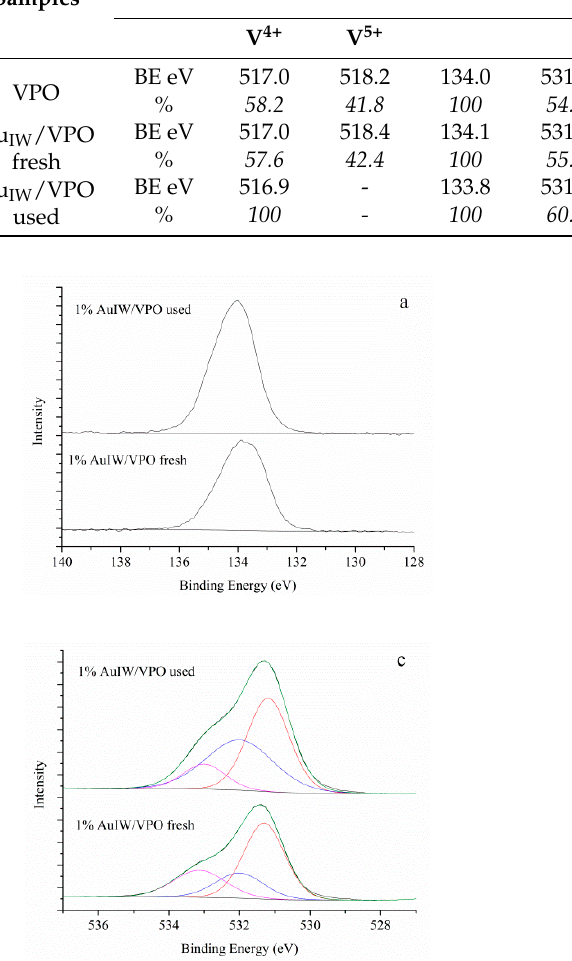
Figure 7. XPS Spectra of the ( a ) P1s, ( b ) V2p, ( c ) O1s and ( d ) Au4f regions of fresh and used 1% Au IW /VPO